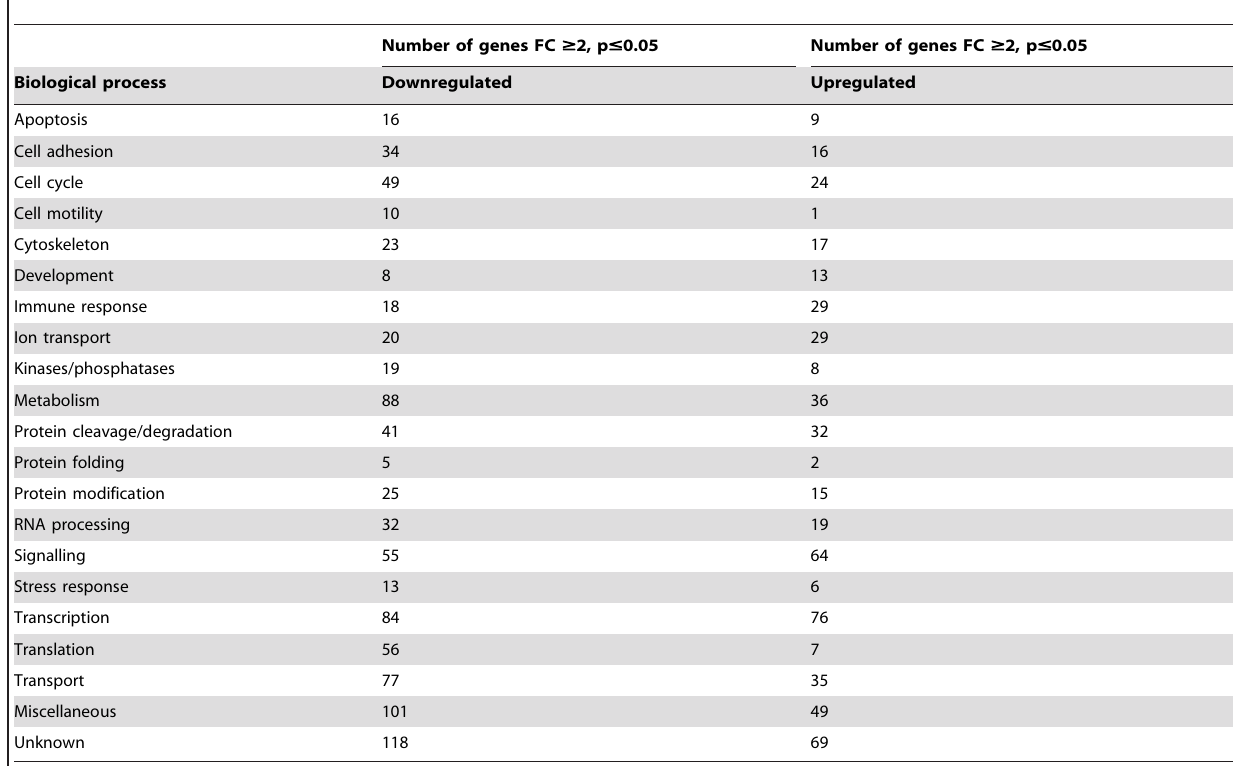
Table 3. Grouping of 891 downregulated and 556 upregulated genes, with a fold change (FC) $ 2, and p value # 0.05, into their biological process, as defined by GeneOntology